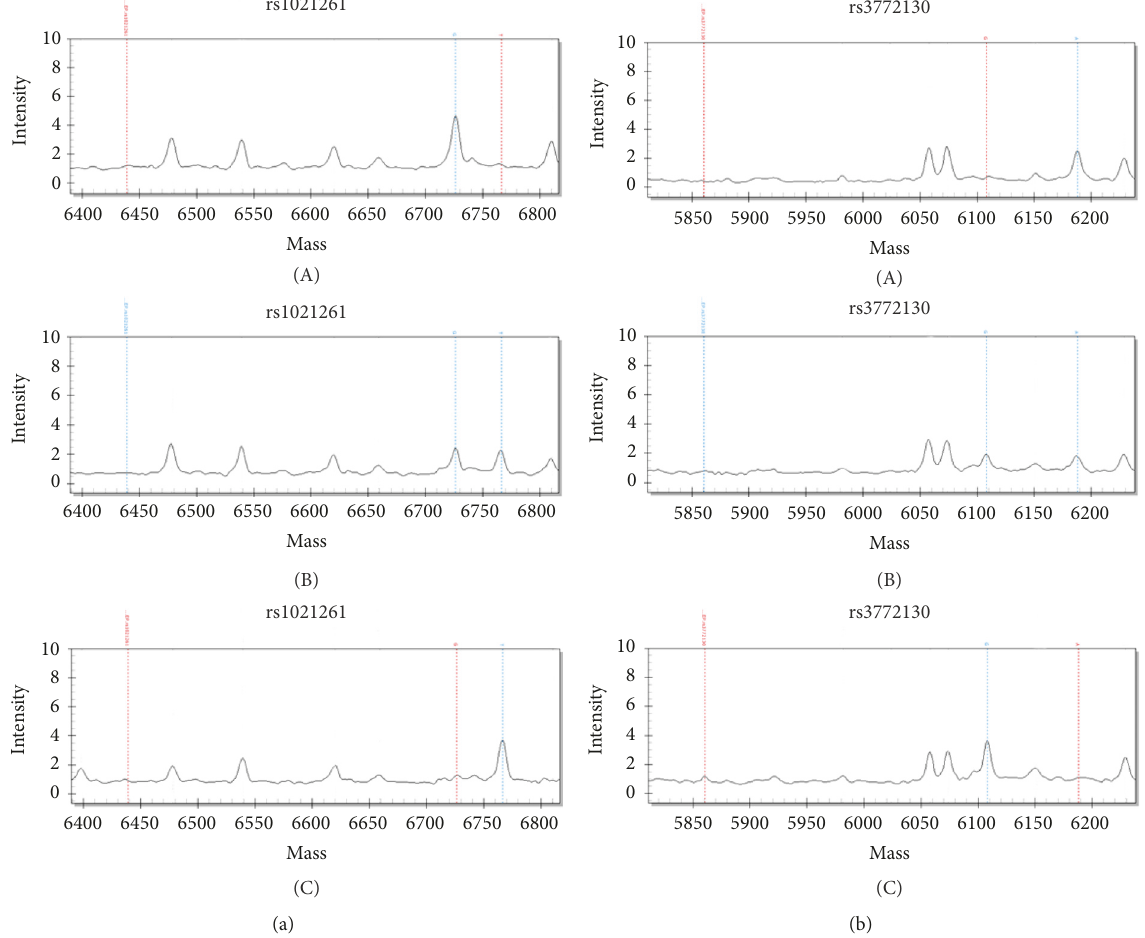
Figure1:SinglenucleotidepolymorphismgenotypingbyMALDI-TOFmassspectrometryonSequenomMassARRAY4platform.Fragments of mass spectra of specimens with different genotype. (a) Rs1021261: GG (A), GT (B), and TT (C). (b) Rs3772130: AA (A), AG (B), and GG